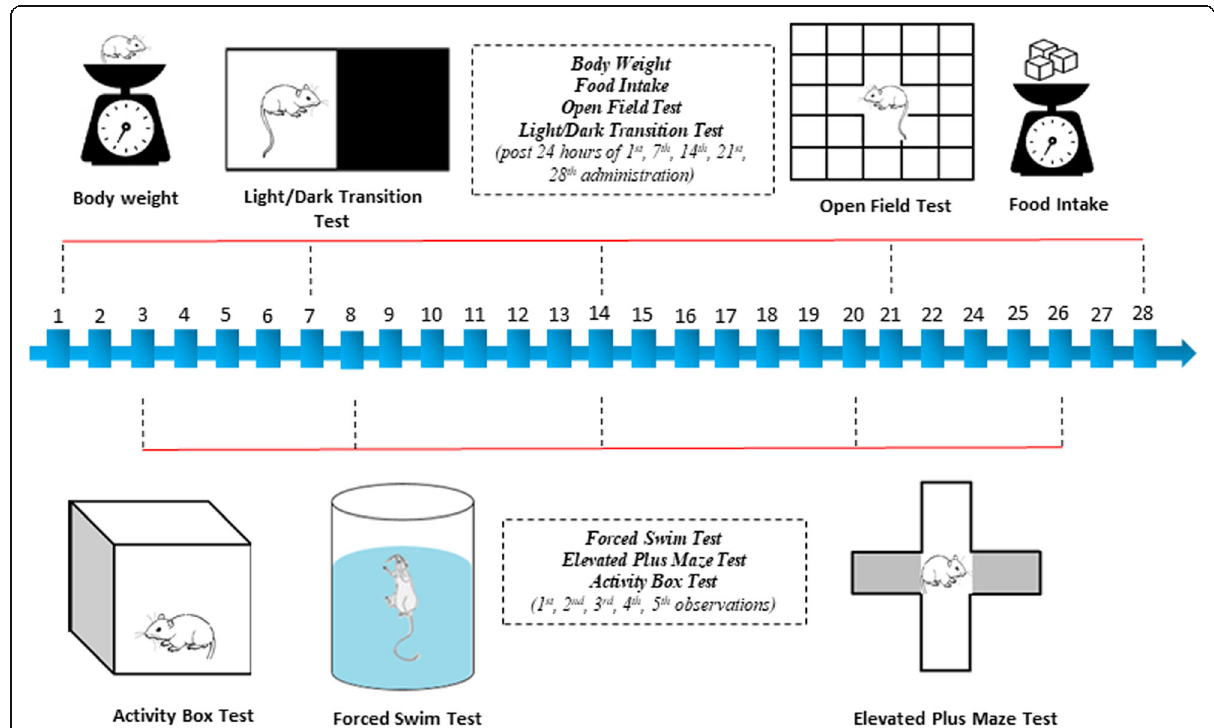
Fig. 2 Schematic representation of experimental protocol and behavioral